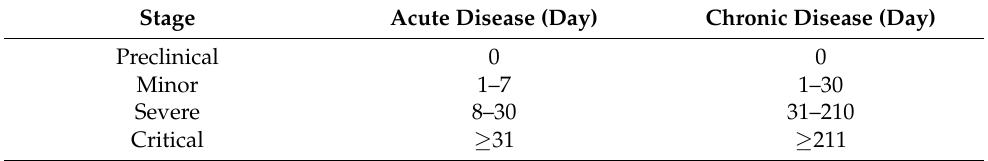
Table 3. Classification of disease’s